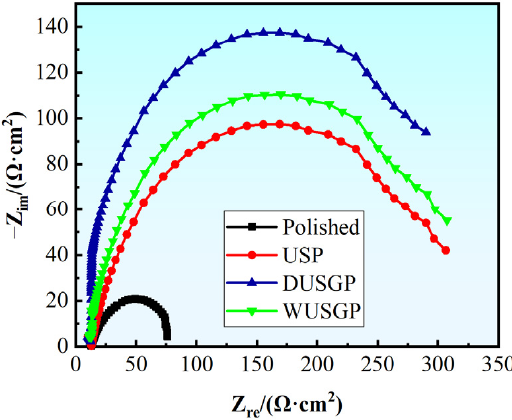
Figure 3. Nyquist plots of the samples immersed in seawater for 96 h.